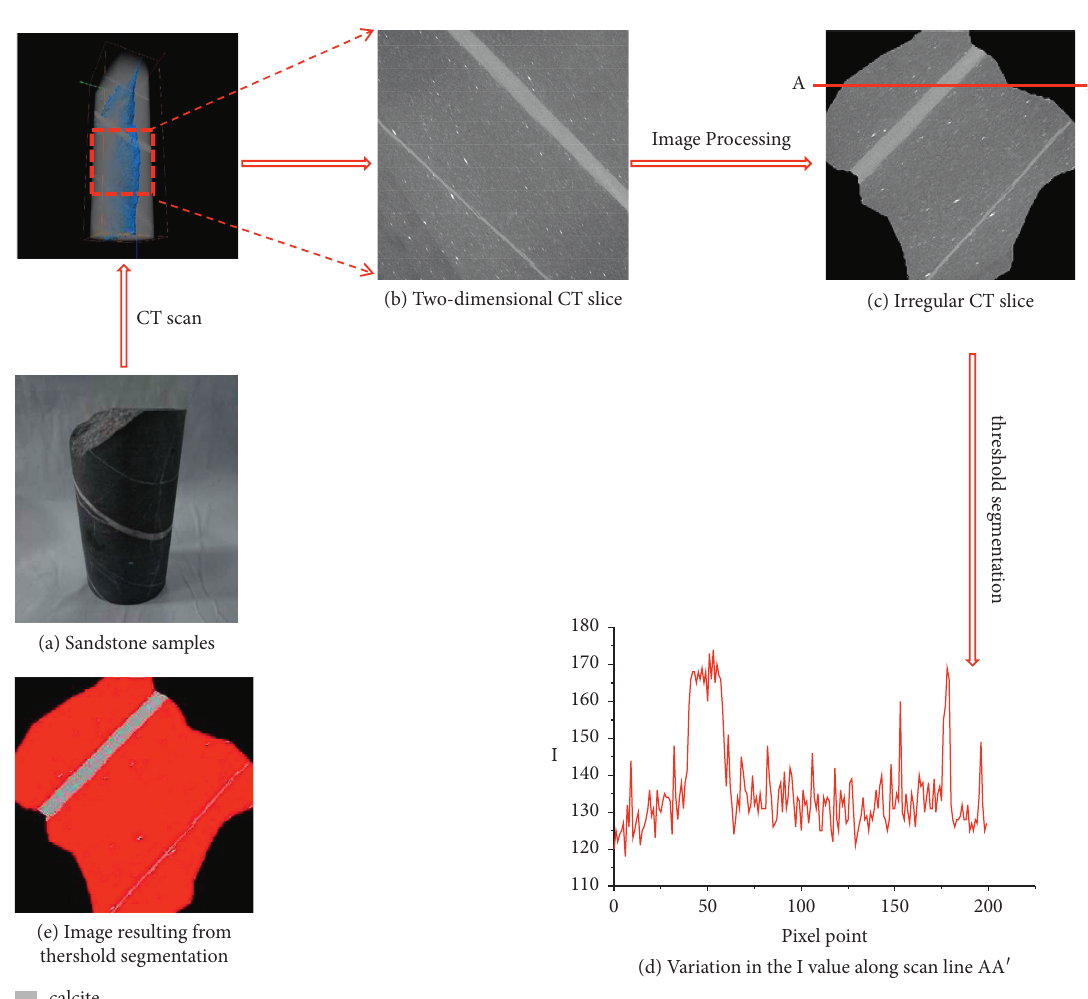
Figure 1: Irregular particle digital image processing process. (a) Sandstone samples. (b) Two-dimensional CTslice. (c) Irregular CTslice. (d) Variation in the I value along scan line AA ′ . (e) Image resulting from threshold segmentation.